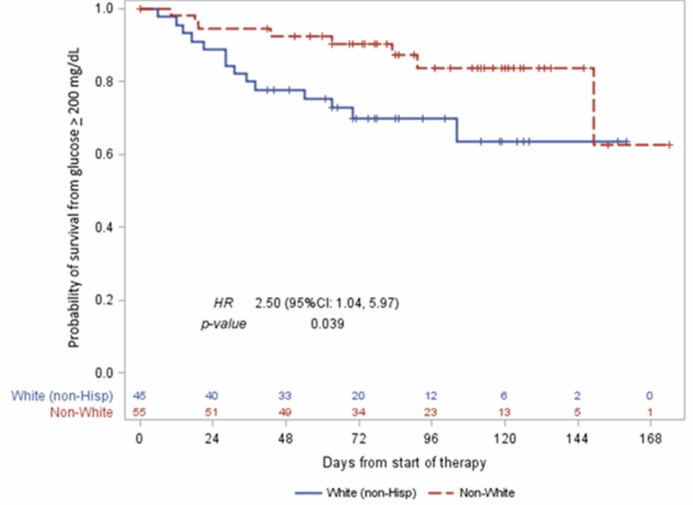
Figure 3. Kaplan–Meier univariate proportional hazard model between non-Hispanic White (non- Hispanic) and non-White patients for time to elevated blood glucose > 200 mg/dL. Race/ethnicity showed a statistical significance in the univariate